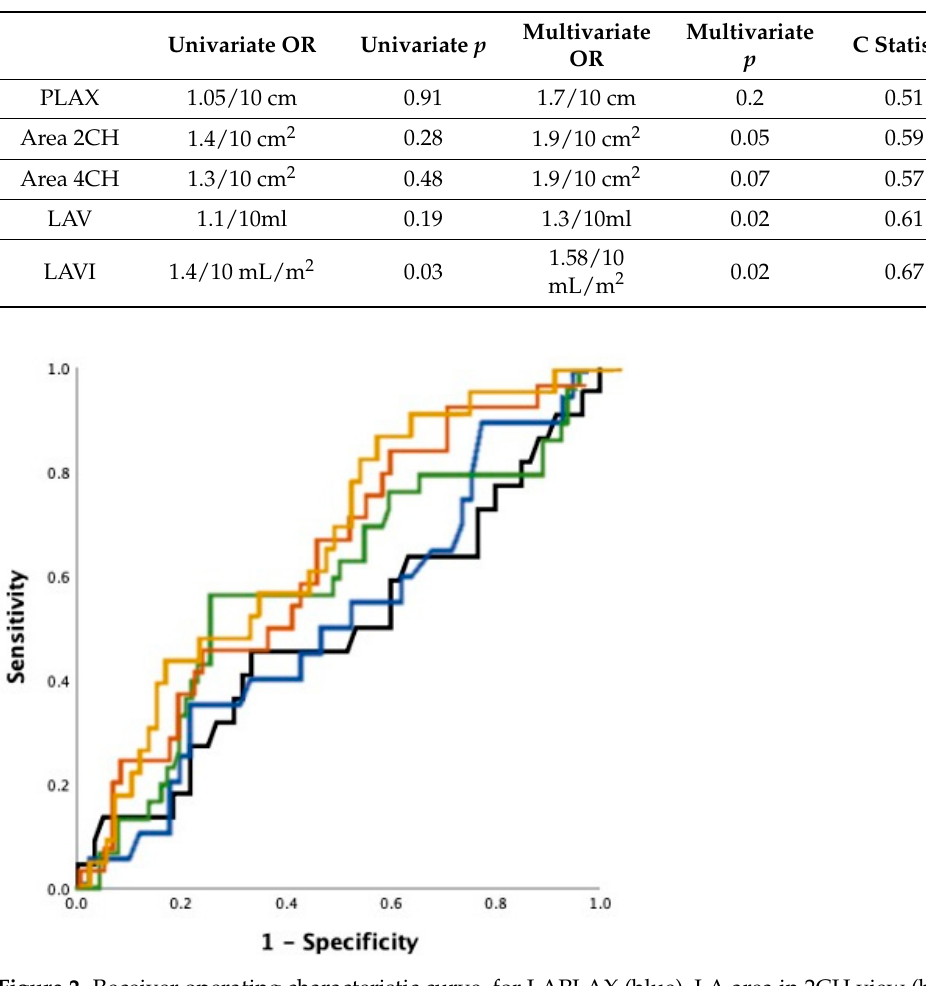
Figure 2. Receiver operating characteristic curve, for LAPLAX (blue), LA area in 2CH view (black) and 4CH view (green), LAV (brown) and LAVI (gold).